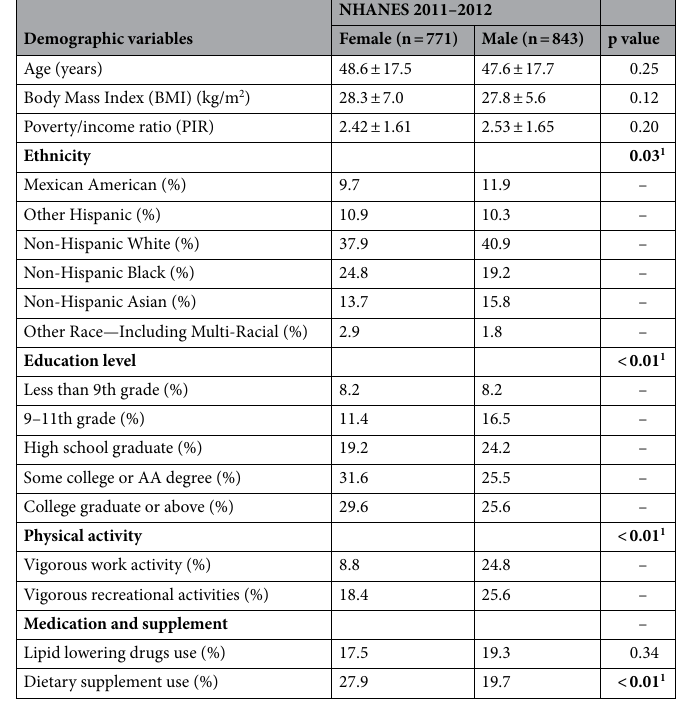
Table 1. Demographics characteristics of studied females and males in NHANES 2011–2012. 1 p-value refers to differences for the category as a